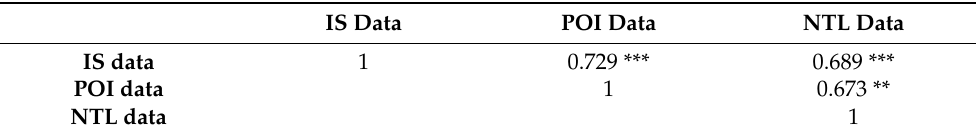
Figure 5. Result of the linear fitting of reference and experimental data of the IS. Table 2. Pearson correlation coefficients between all variables in the township scale (***—at the 1% level, **—at the 5% level).